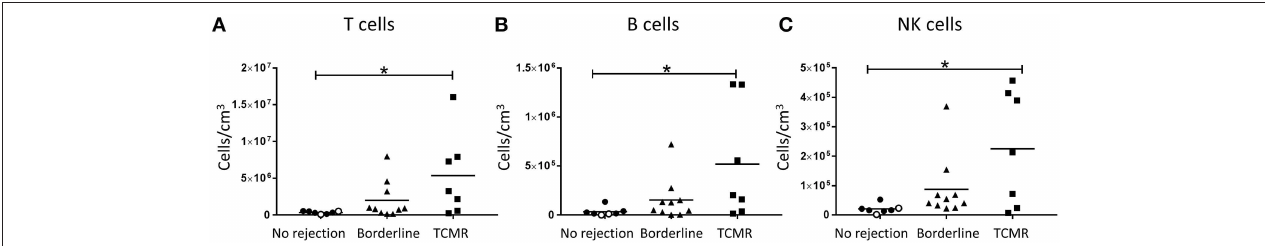
FIGURE 2 | Significantly increased T cells, B cells, and NK cells in TCMR. Absolute numbers of total (A) T cells, (B) B cells, and (C) NK cells in kidney transplant biopsy tissue with histopathological diagnosis of no rejection ( n = 7), borderline cellular rejection ( n = 10), and T cell-mediated rejection (TCMR; grades I–II; n = 7). Values for